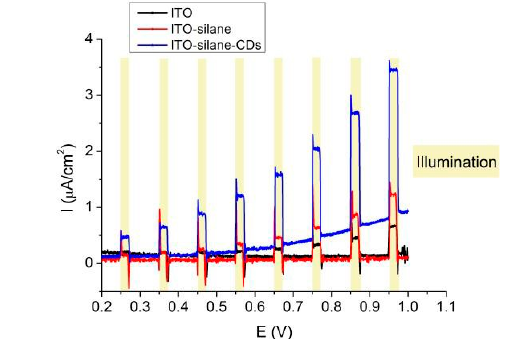
Figure 1. LSV curves of ITO, ITO-silane, and ITO-silane-CDs with chopped illumination (420–450 nm, 10 mW/cm 2 ).